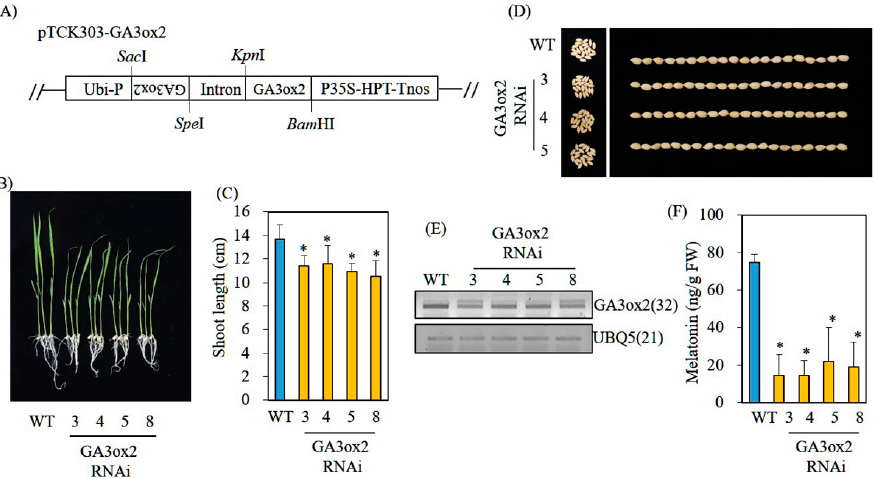
Figure 5. Structure of binary vector pTCK303-GA3ox2 and the generation of GA3ox2 -suppressed transgenic rice plants. ( A ) Schematic diagram of the pTCK303:GA3ox2 binary vector. ( B ) Seven-day- old rice seedling phenotypes of wild-type (WT) and GA3ox2 RNAi transgenic rice (T 2 ). ( C ) Shoot length measurement. ( D ) Seed phenotype. ( E ) RT-PCR analysis results for WT and T 2 lines. ( F ) Mel- atonin levels of WT and transgenic lines. Seven-day-old rice seedlings challenged with 0.5 mM cad-